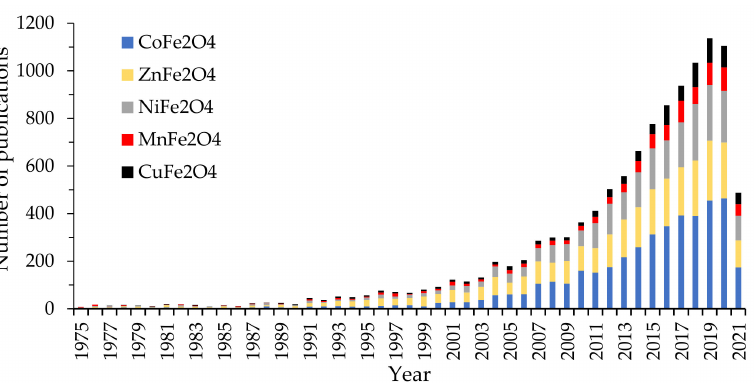
Figure 1. Papers having M-ferrite (M = Co, Cu, Ni, Mn, Zn) in the topic published in Web of Science Core Collection between 1975–June